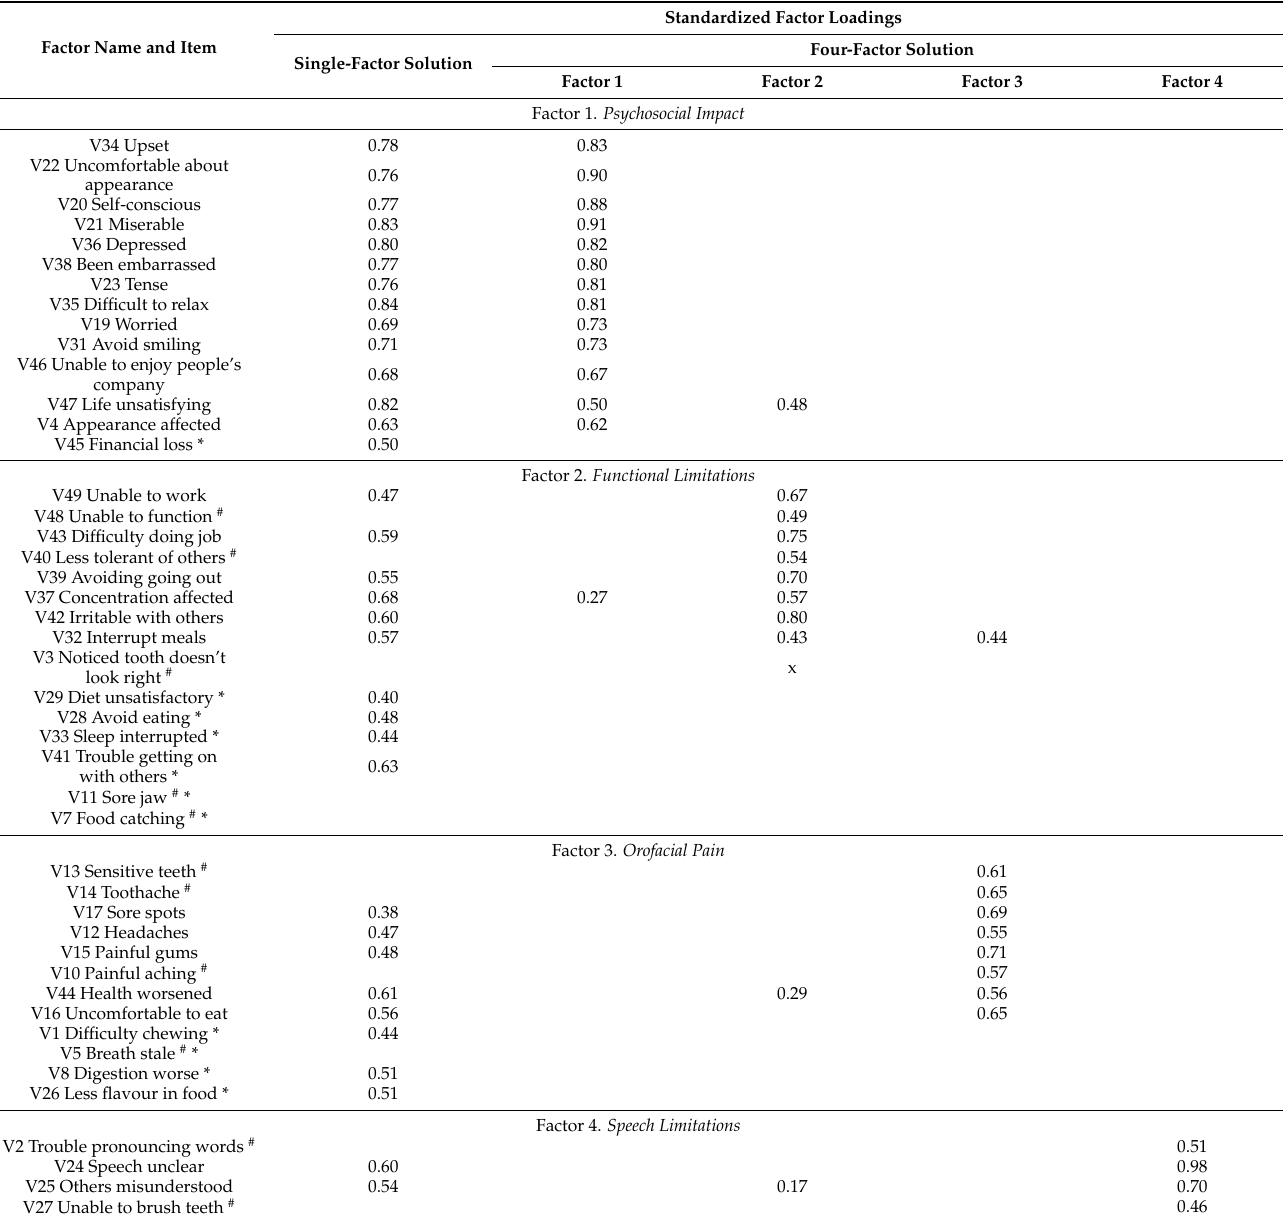
Table 3. Results of confirmatory factor analysis: standardized factor loadings in the single-factor (37 items) and four-factor (34 items) solution of the